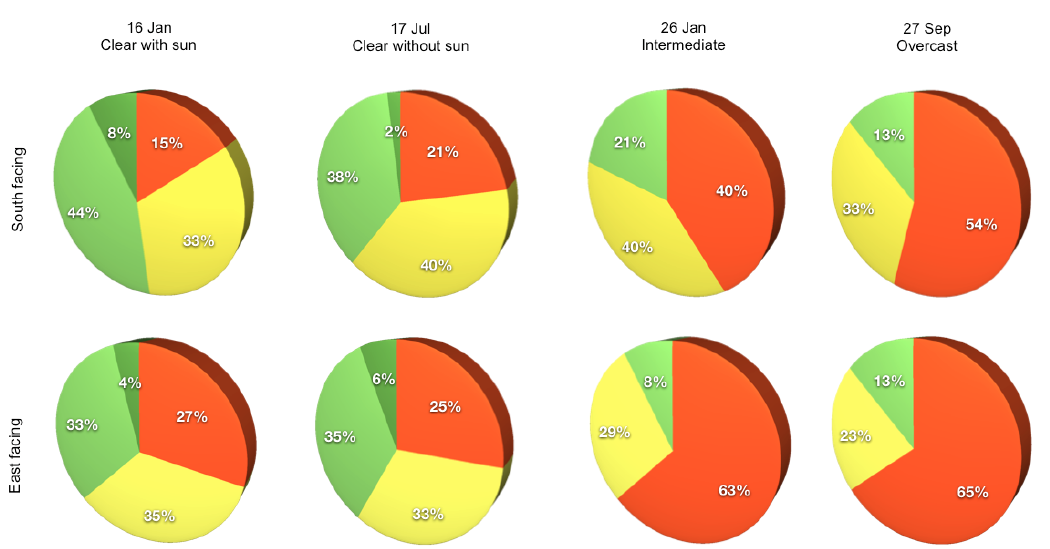
Figure 11. Daylight analysis of the office base case positioned at the south orientation, during a clear sky day. Above: table showing daylighting levels along the day at four points of the floor plan of the base case. Middle: graphic representation of the information presented in the table above. Bottom: images of the simulations showing the distribution of daylight across the floor plan at three points in the day.